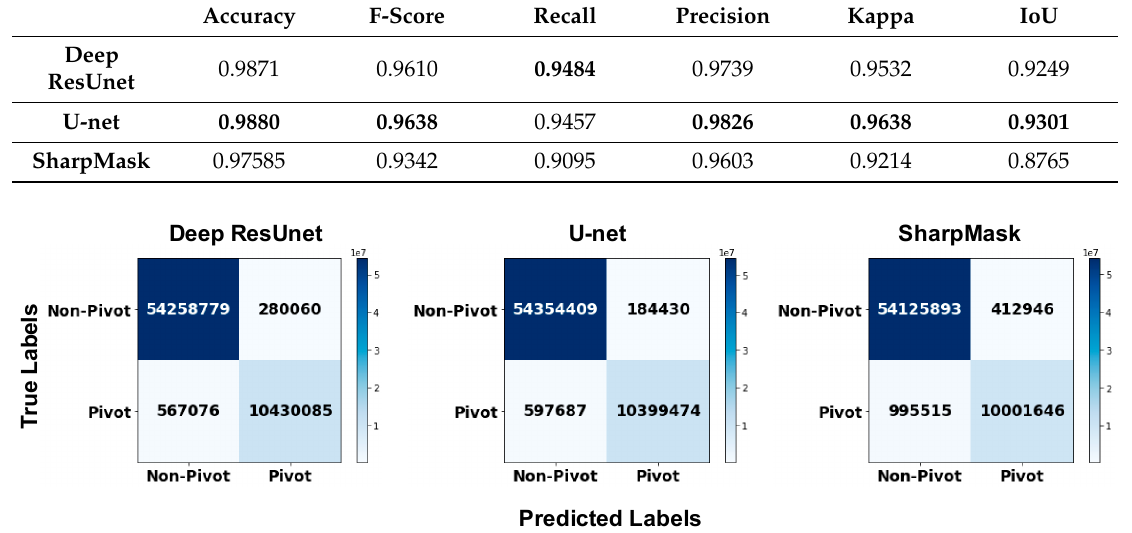
Figure 7. Deep ResUnet, U-net, and SharpMask confusion matrices, considering a pixel-wise analysis.